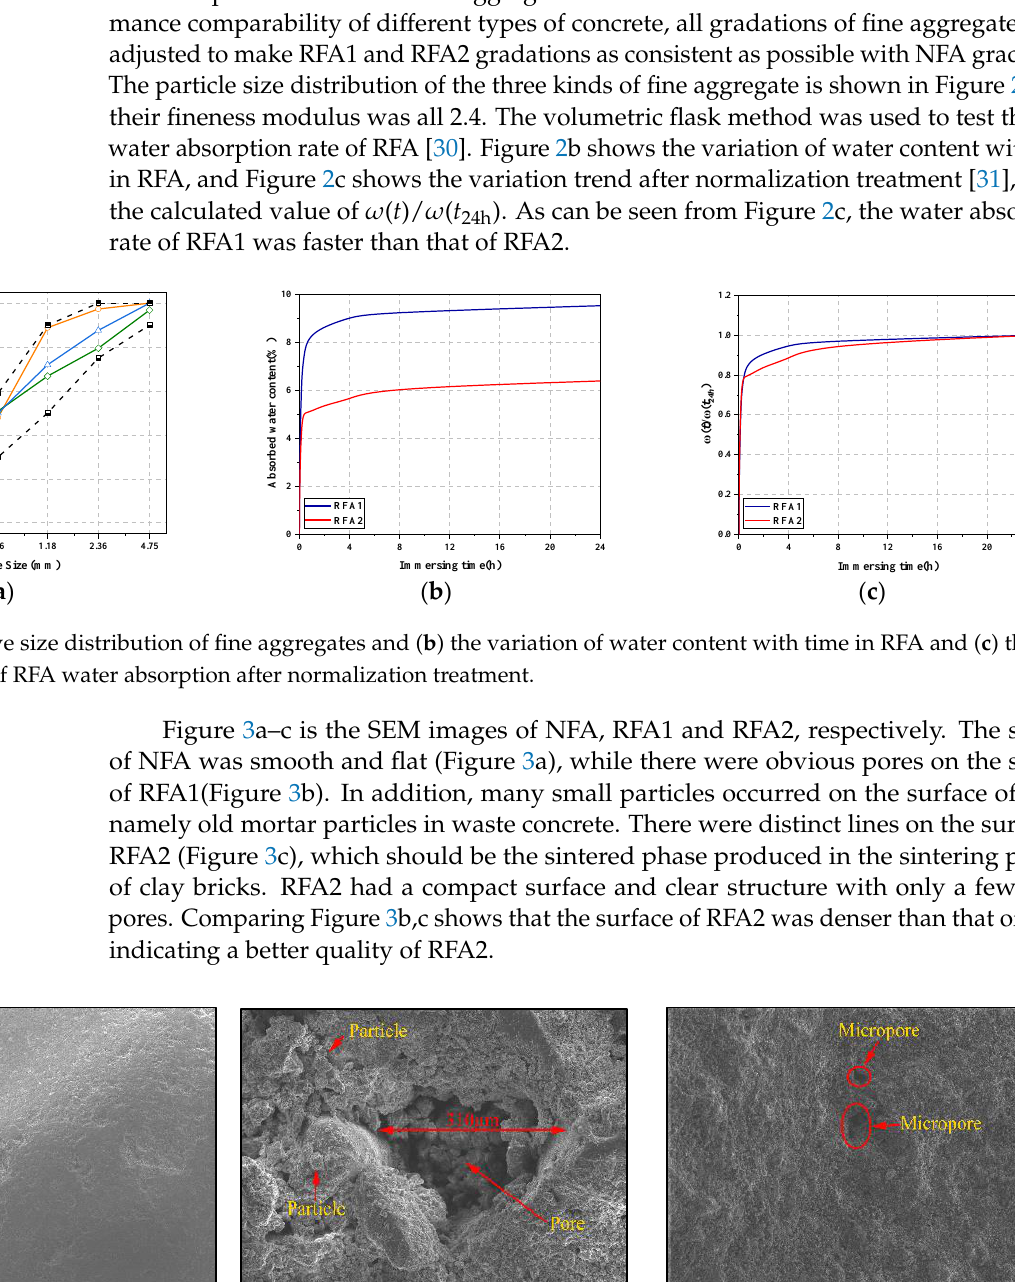
Table 3. Physical properties of natural and recycled aggregate.